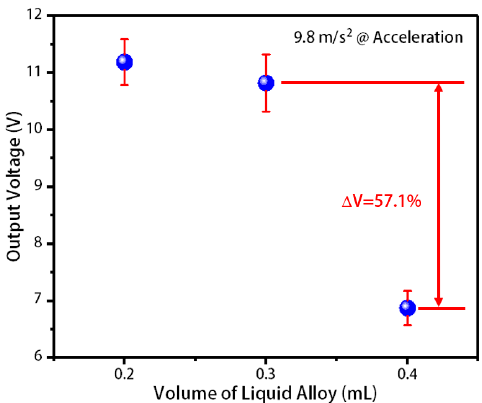
Figure 8. The open-circuit voltage of three groups of flexible and stretchable energy harvesters under the press of gravity acceleration.